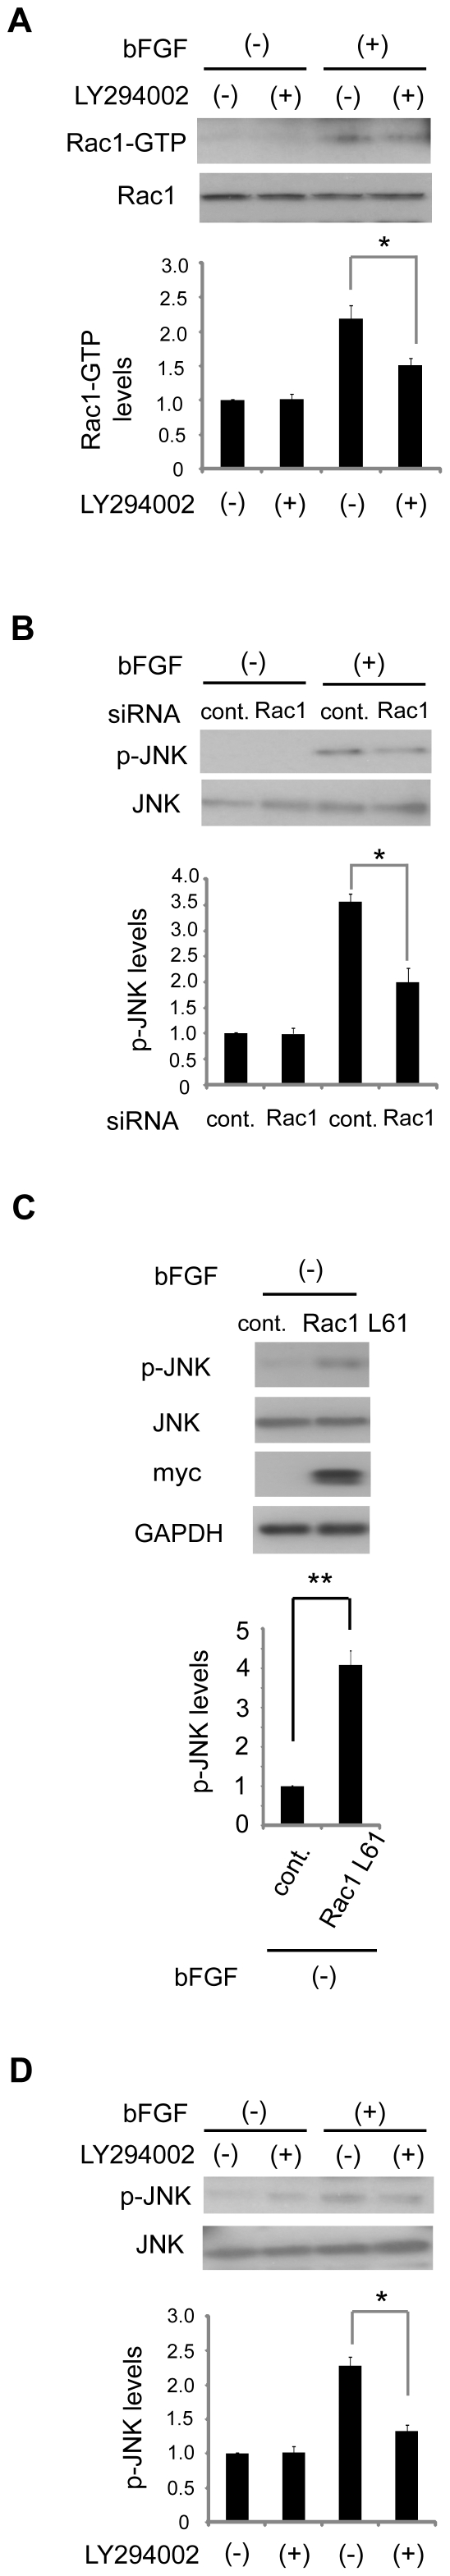
PI3-kinase contributed to bFGF-induced Rac1 and JNK activation.(A)(D) The activities of Rac1 or JNK in lysates of fibroblasts treated with or without 10 µM LY294002 were analyzed at 15 min after 100 ng/ml bFGF-stimulation in the presence of 5 µg/ml mitomycin-C. (B) The activity of JNK in lysates of fibroblasts transfected with 10 nM Rac1 siRNA or 10 nM nonspecific control pool siRNA was analyzed at 15 min after 100 ng/ml bFGF-stimulation in the presence of 5 µg/ml mitomycin-C. (C) The activity of JNK without bFGF in lysates of fibroblasts transfected with 0.15 µg/cm2 of plasmid DNA (Rac1-61L) or empty vector as a control was analyzed in the presence of 5 µg/ml mitomycin-C. Data are mean ± s.e.m. of three independent experiments. *P<0.05, **P<0.01, as compared with the control group (t test).